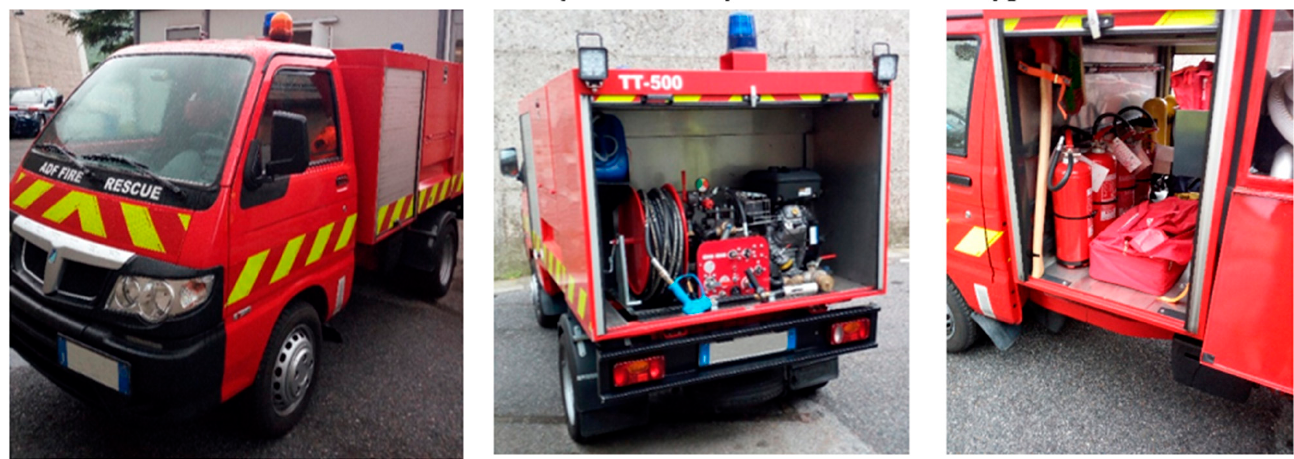
Figure 2. Emergency vehicle equipped with a micronized water system (nominal tank capacity equal to about 500 litres), and 4 portable extinguishers.